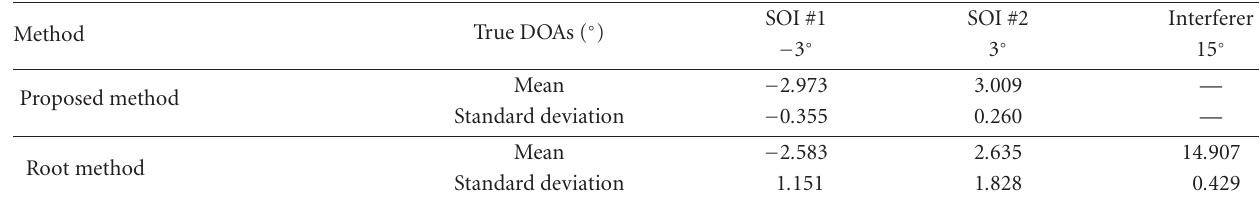
Table 1: Mean and standard deviations for both methods.